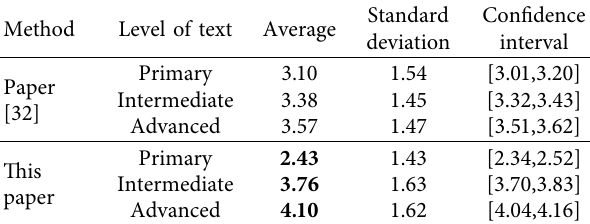
Table 10: Comparison of sentence semantic complexity.